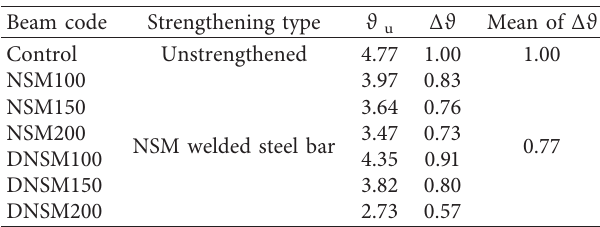
Figure 14: Torque versus twist angle of each concrete beam. Table 4: Specimens’ twist ratio.